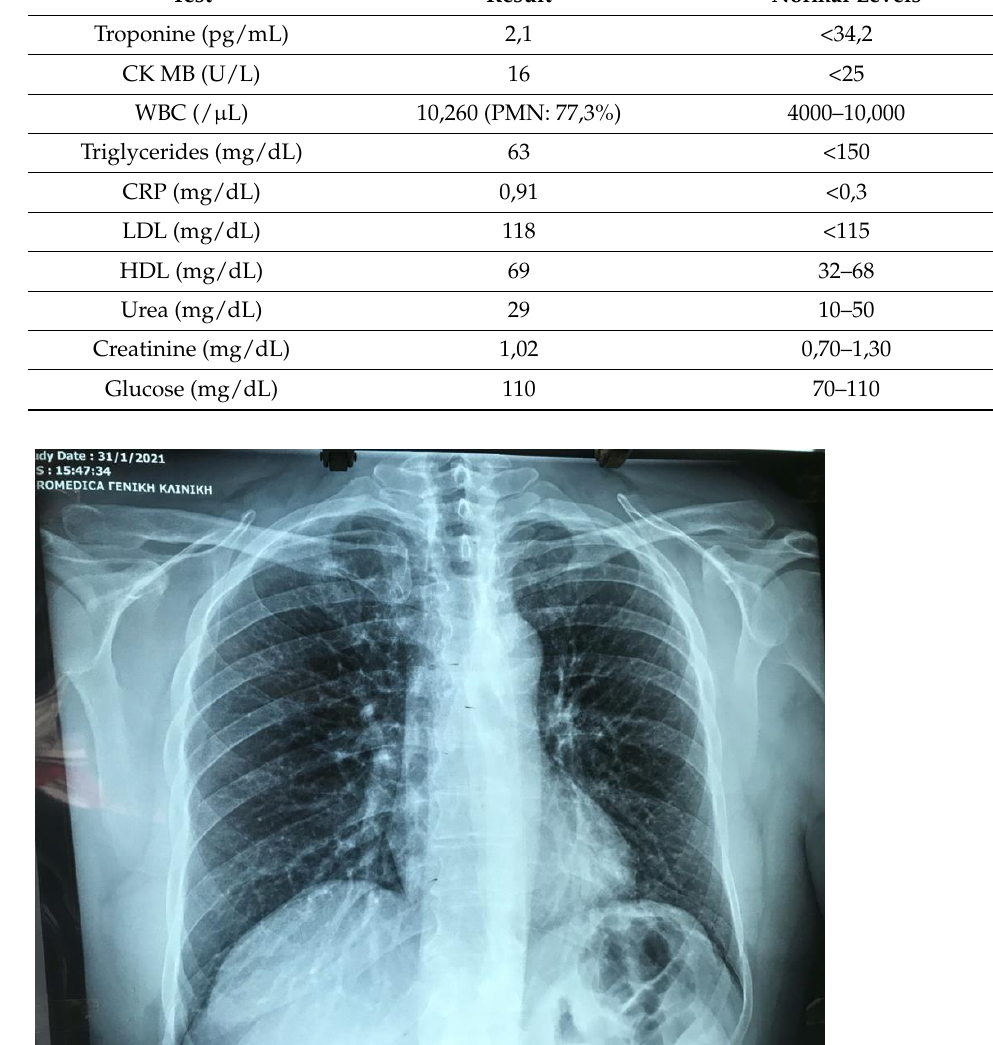
Figure 2. Chest radiography of the patient showing normal radiological